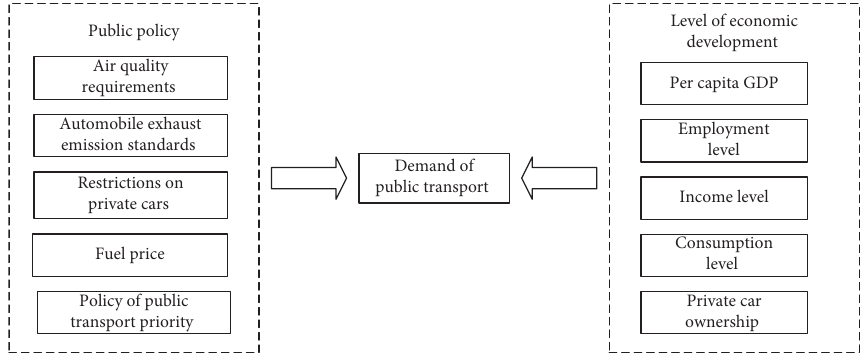
Figure 3: Impact of public policy and level of economic development on the demand for public